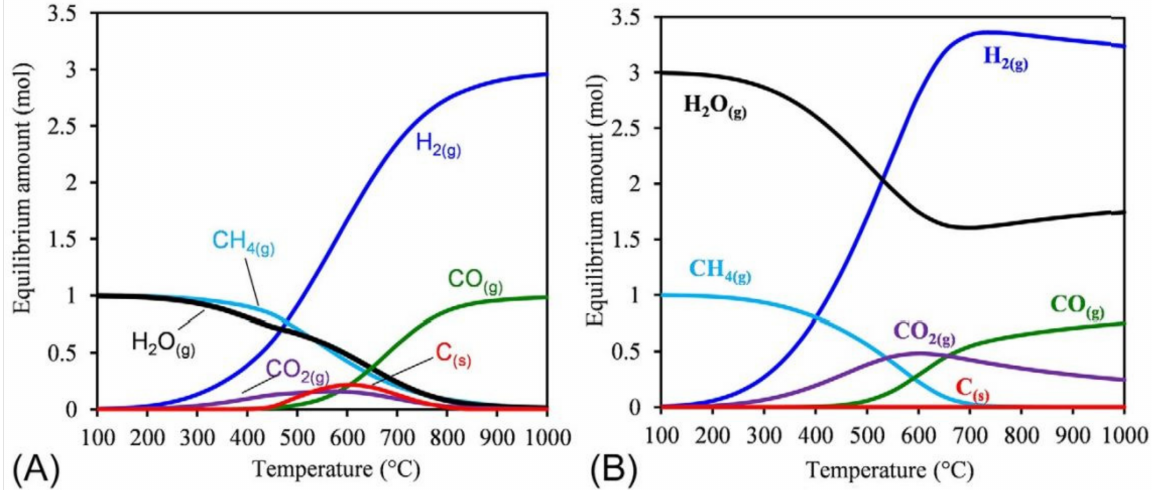
Figure 2. Thermodynamic equilibrium plot for SRM as a function of temperature (T = 100–1000 ◦ C) at 1 bar with ( A ) H 2 O/CH 4 = 1.0 and ( B ) H 2 O/CH 4 = 3.0. Reprinted with permission from [115]. Copyright 2018